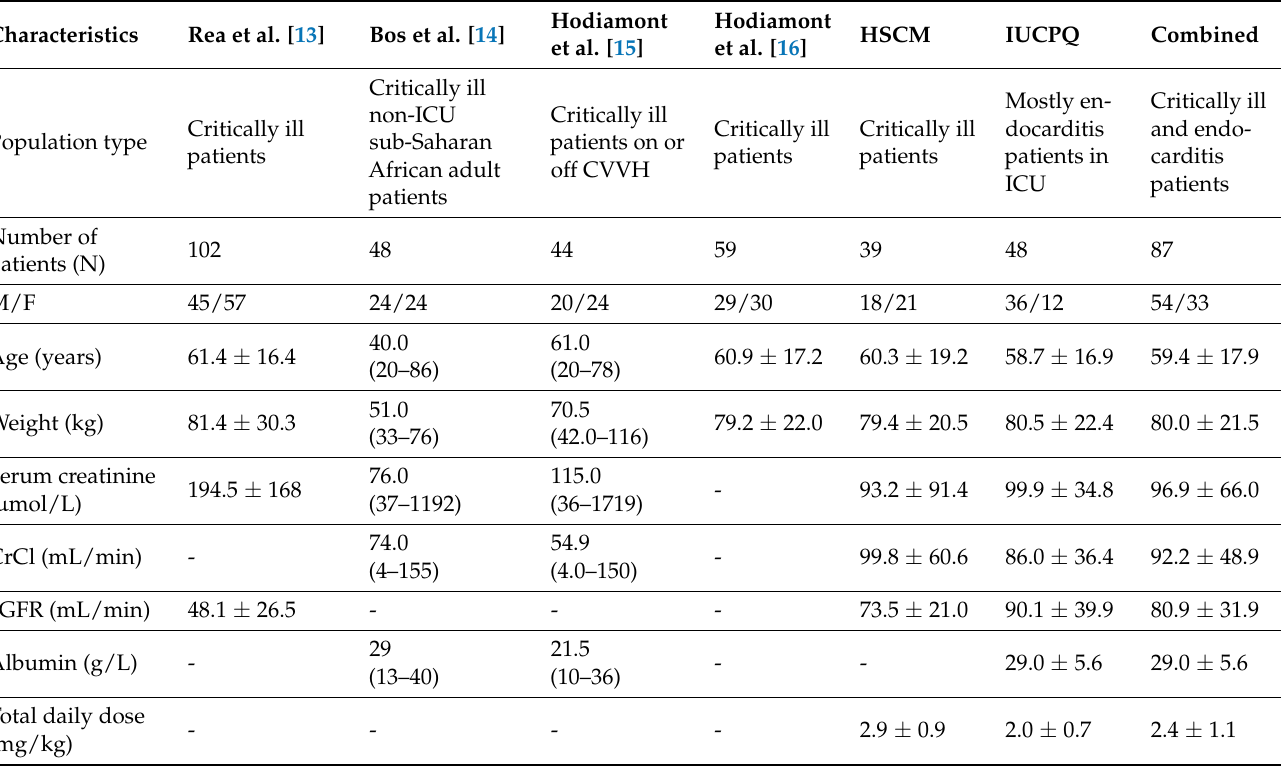
Table 1. Demographic characteristics of the patients in the evaluated models and the external validation datasets.